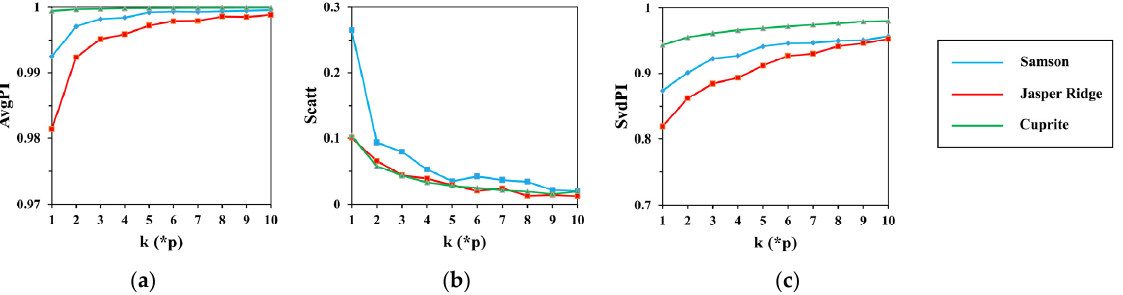
Figure 9. The results of ( a ) Scatt; ( b ) AvgPI; ( c ) SvdPI with the change of k.